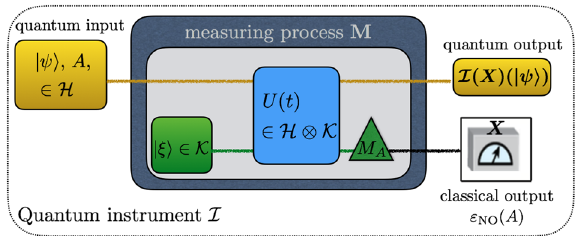
Fig. 1 Model of quantum measuring process. Schematic illustra- tion of the indirect measurement model with noise-operator-based quantum root-mean-square (q-rms) error ε NO ( A ) of measuring process M error measure based on the distance between probability measures, and pointed out several discrepancies between them in favor of the latter. In order to reconcile the con fl ict, Ozawa introduced four requirements for a valid de fi nition of error measure ε generalizing